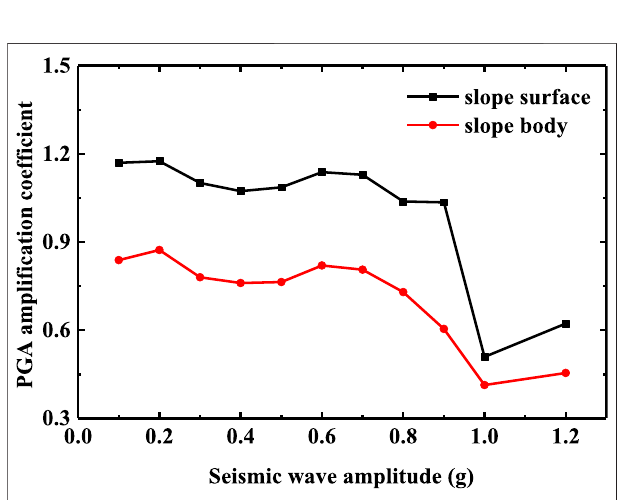
FIGURE 11 | Difference of PGA ampli fi cation coef fi cient between slope surface and slope body (the slope